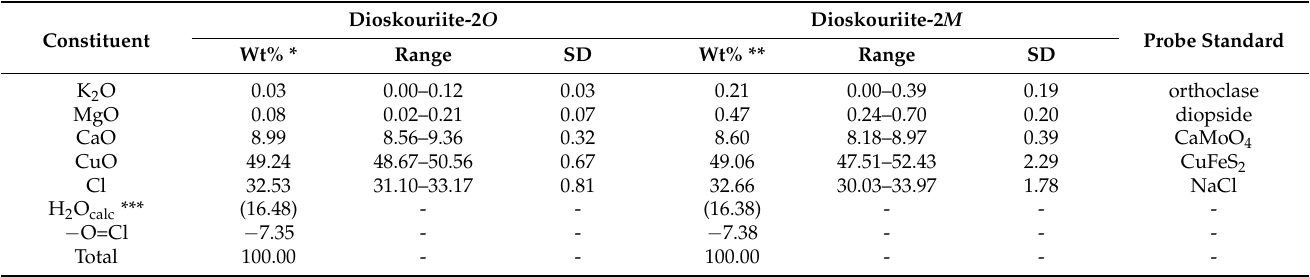
Table 1. Chemical composition of Table 1 . Chemical composition of dioskouriite.